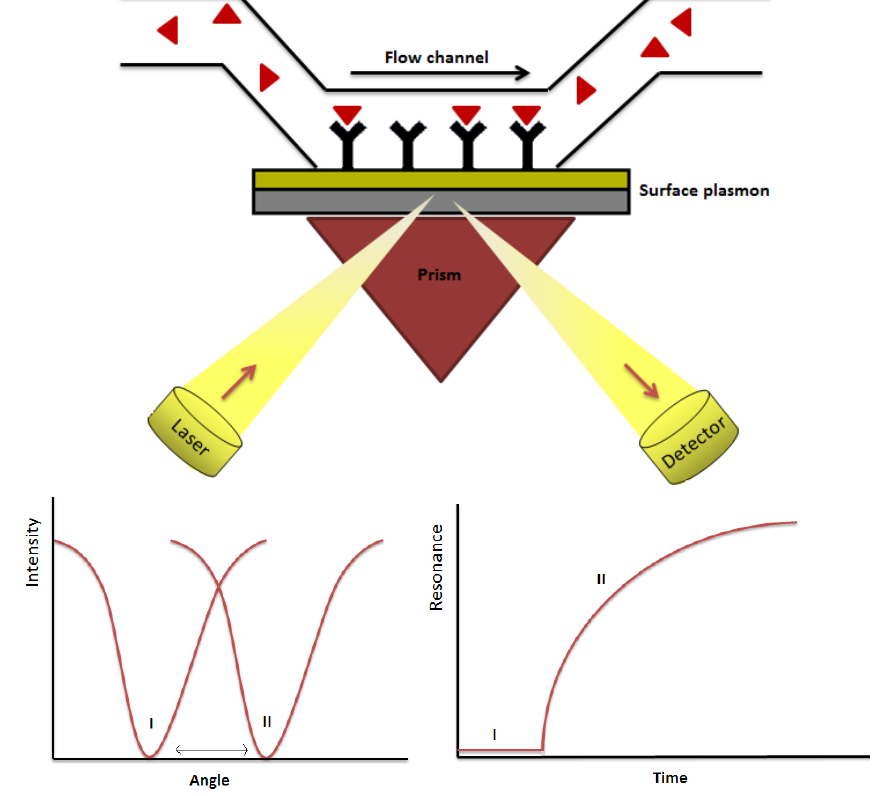
Figure 3. Schematic description of Surface Plasmon